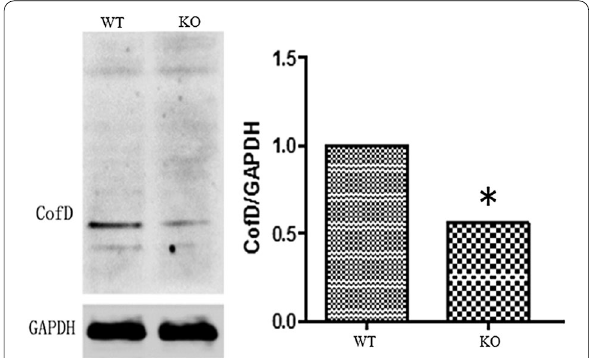
Fig. 2 The differences protein expression (mean) of cofD in WT and KO M. ruminantium . Strains were incubated at 30° C for 72 h.